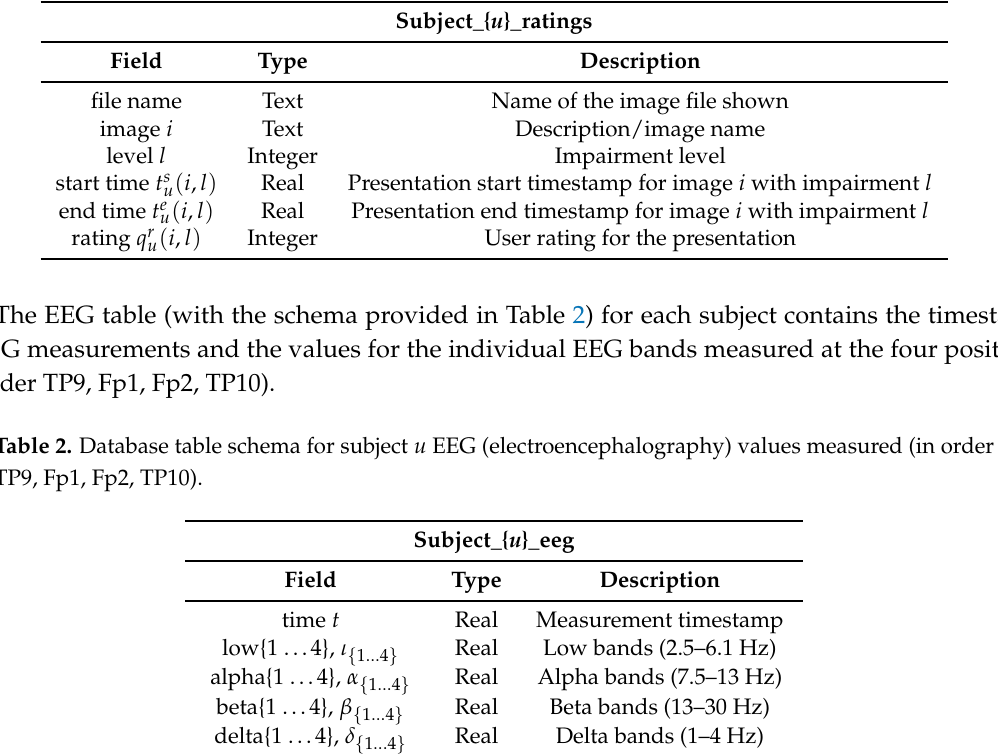
Table 1. Database table schema for subject u media presentation and ratings; Text: SQLite variable-length string data type; Integer: SQLite integer number data type; Real: SQLite floating point number data type.